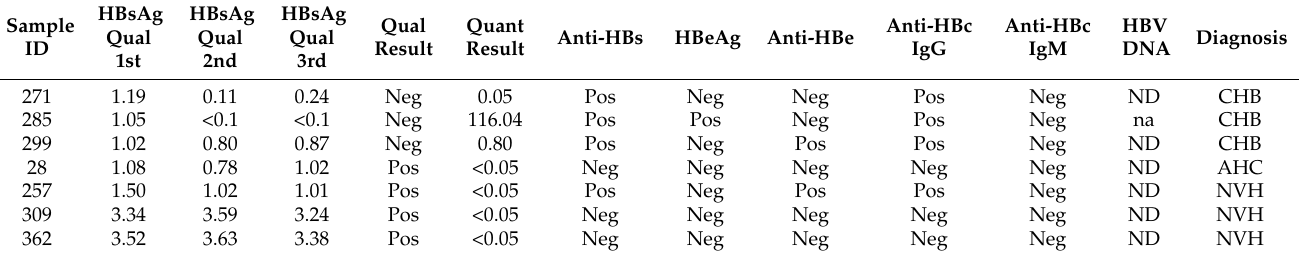
Table 2. Serologic test results of seven discordant HBsAg samples measured by Elecsys HBsAg II Quant and ADVIA Centaur HBsAg II